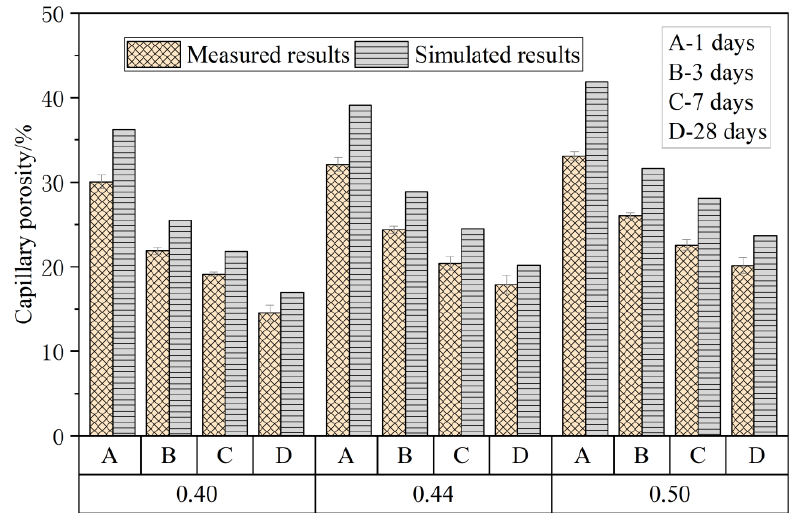
Figure 7. Measured and simulated capillary porosity of cement stone. The relative deviations between the simulated results and measured results were 13.95~20.43%, 13.04~21.73%, and 17.56~25.31%, while the water–cement ratios were 0.40, 0.44, and 0.50,